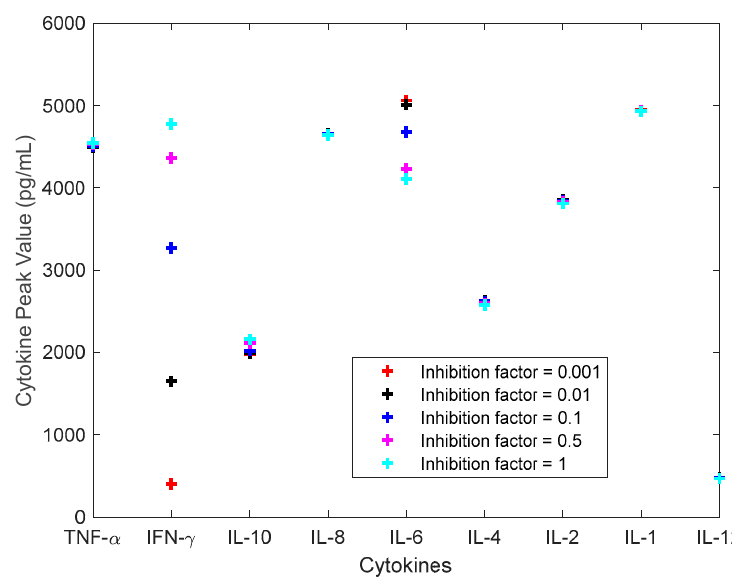
Figure 5. the cytokine concentrations for the inhibition of INF- γ . Figure 5. The cytokine concentrations for the inhibition of INF- γ